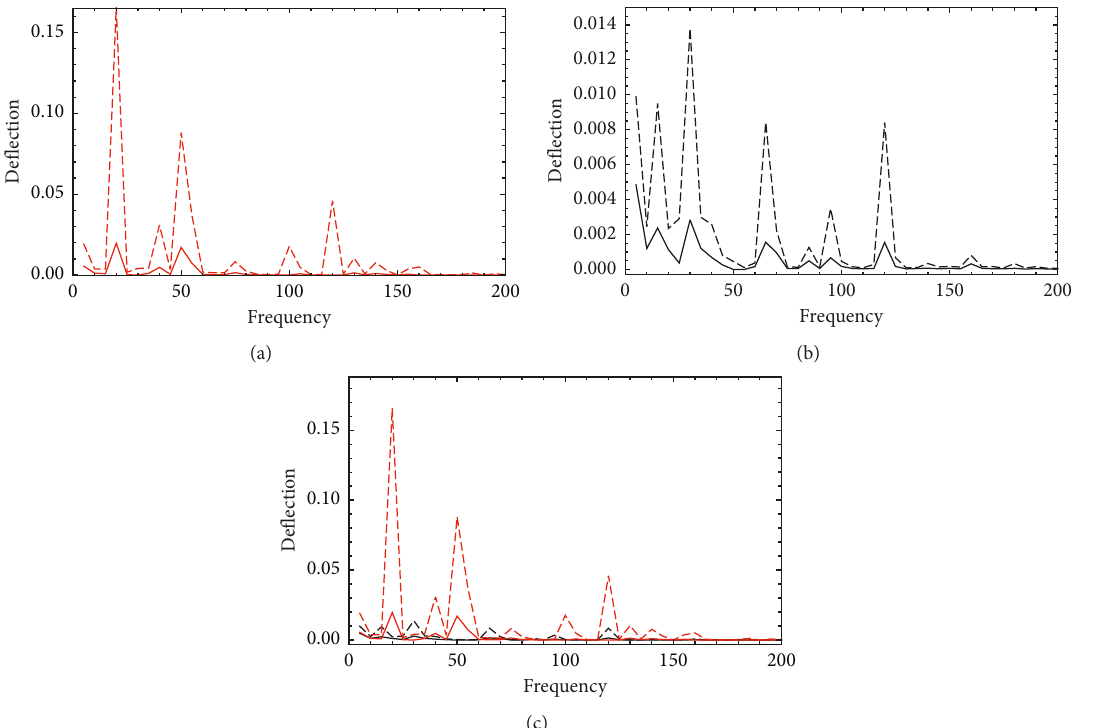
Figure 11: Frequency response: comparison of partial sparse grids: X GL vs X CC ; maximal transverse deflection w line represents the added standard deviation. (a) Gauss X GL p � 2, 25 points. (b) Clenshaw–Curtis X CC p � 2, 25 points. (c)